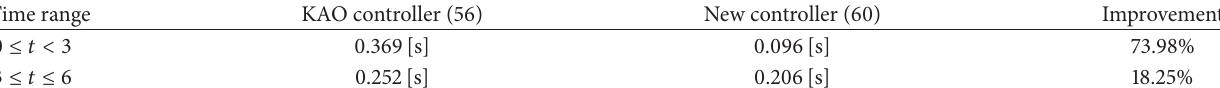
Table 2: Comparison of the settling times for the KAO controller (56) and the new controller (60).